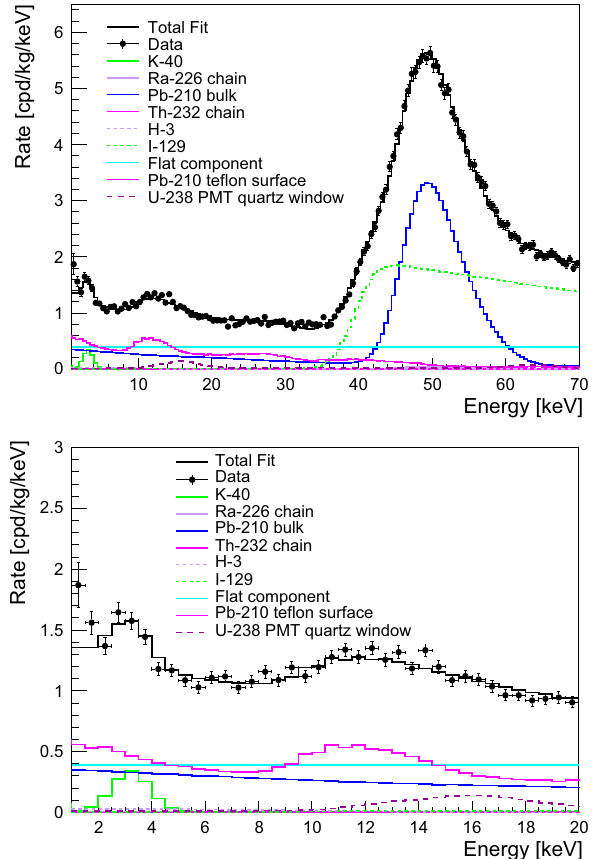
Fig. 9 PoP-dry energy spectrum of the NaI-33 crystal up to 70 keV (top) and below 20 keV (bottom) with a spectral fit. Data are shown after noise rejection and acceptance